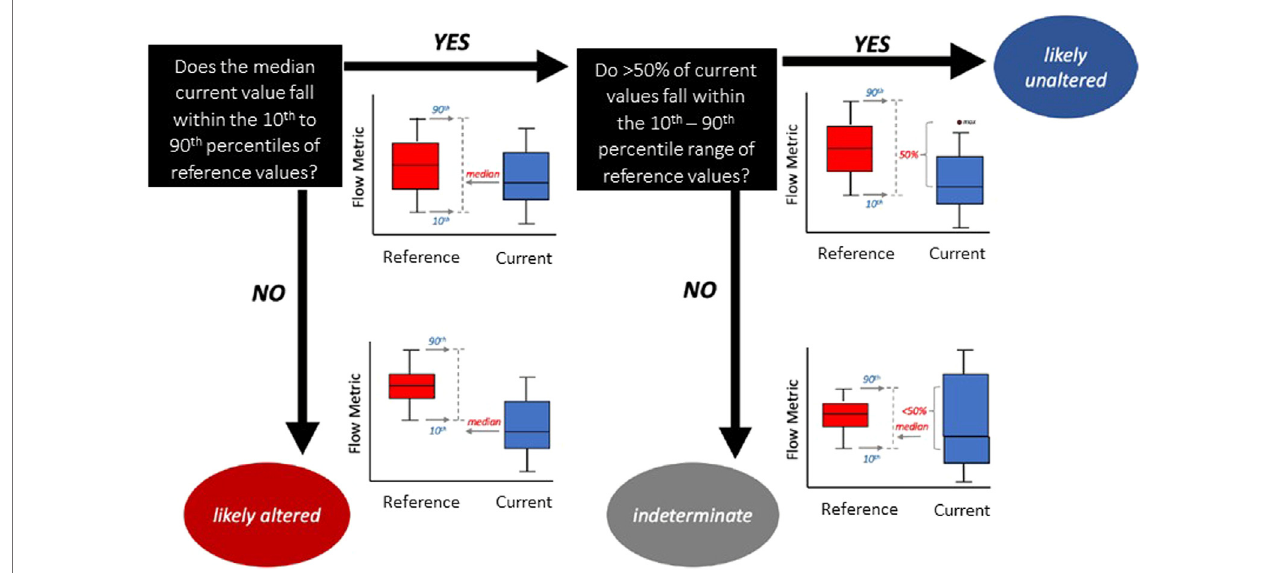
FIGURE2| Criteriaforassigningalteration status adapted from CEFFAppendixJ (inreview).Alteration wasevaluatedbasedonthe deviationofcurrent fl owsfrom reference conditions and the deviation of current fl ows from re fi ned ecological fl ow needs identi fi ed.